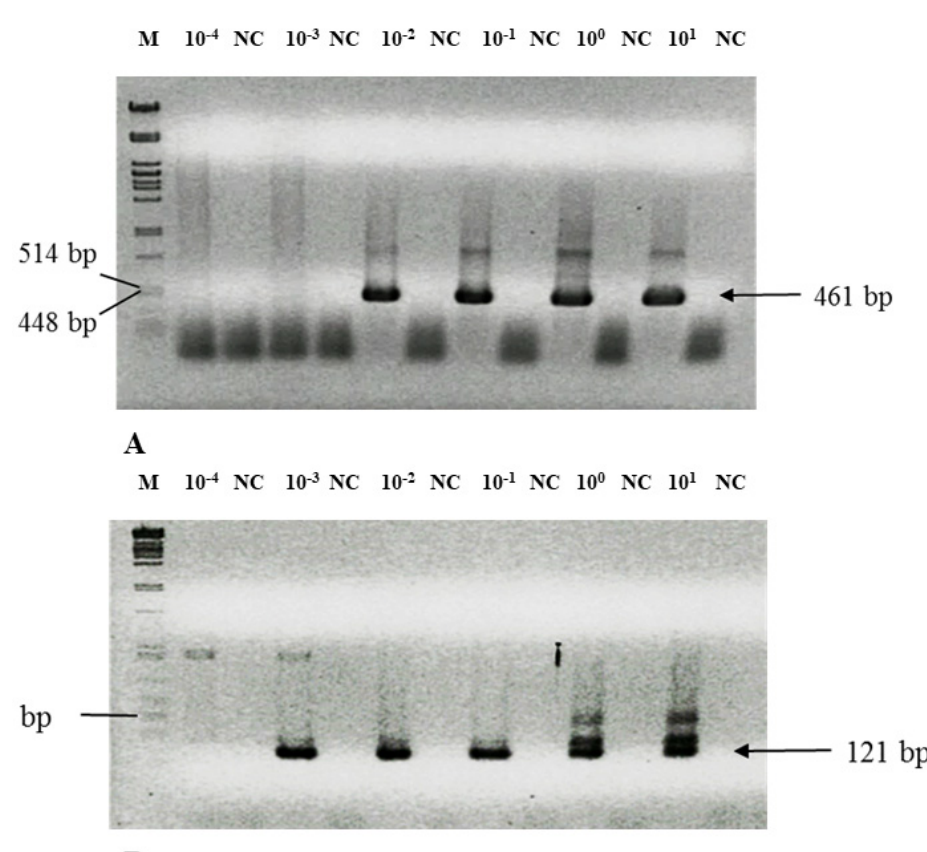
Figure 1. Threshold value of the NPCR assay for C. pneumoniae detection in sputa. Lines: M λ / Pst I size marker; 500 µ L of negative sputum was spiked with 1 µ L of 10 − 4 –10 1 dilution of original culture C. pneumoniae TWAR-183; DNA was isolated as described in the Materials and Methods section, and 0.5 µ L was added to the first PCR reaction, amplified by external primers, and 1 µ L was amplified in the second reaction; 10 − 4 –10 1 serial dilutions; NC negative controls. ( A ) PNEU S/PNEU Nok; Chp up/Chp down primers. Size of PCR product is 461 bp. ( B ) PNEU S/Short down; Short up/a Chtinok primers. Size of PCR product is 121